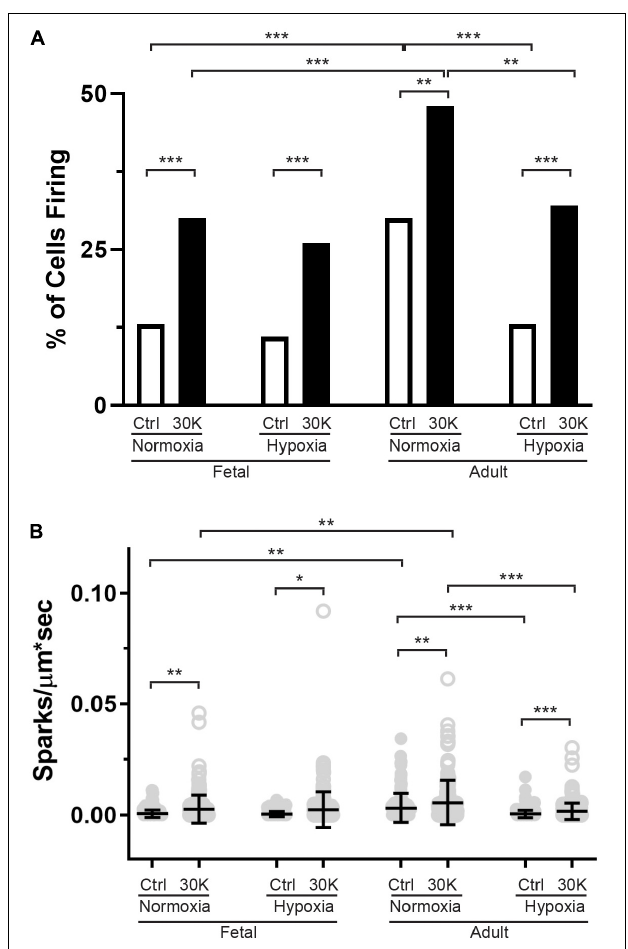
FIGURE 9 | The incidence of Ca 2 + sparks activated by membrane depolarization is reduced in fetuses and by hypoxia in adults. (A) percentage of cells with or without Ca 2 + sparks and (B) Ca 2 + spark firing frequency. Bars represent mean ± SD for each condition. Clear bars and closed circles specify control conditions, while black bars and open circles treatment with 30 K. Data in A were analyzed by a chi-square test while data in (B) were analyzed by Kruskal–Wallis one-way ANOVA with Dunn’s multiple comparison test based on ranks for each group * P < 0.05, ** P < 0.01, *** P < 0.001. Recordings were made in FN control (161/3) and 30K (172/3), FH control (171/4) and 30K (185/4), AN control (150/3) and 30K (155/3), and AH control (207/4) and 30K (217/4) lines (cells)/animals,